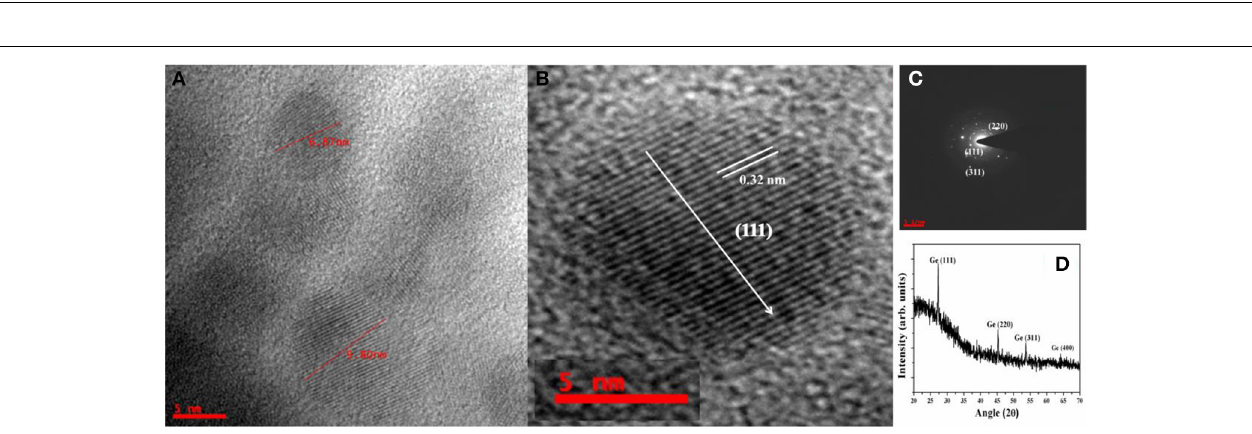
FIGURE 4 | (A–C) are the size distribution histograms of 20mJ (30min duration), 40mJ (30min duration), and 60mJ (30min duration) samples respectively. (D) Shows the elemental composition from the Ge NPs recorded using EDS associated with TEM.